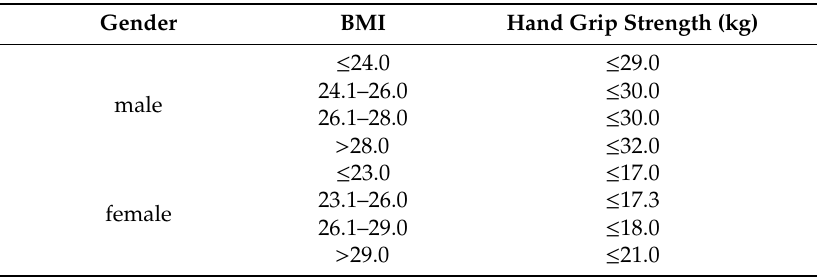
Table 3. BMI adaption: Cut-o ff values hand grip strength